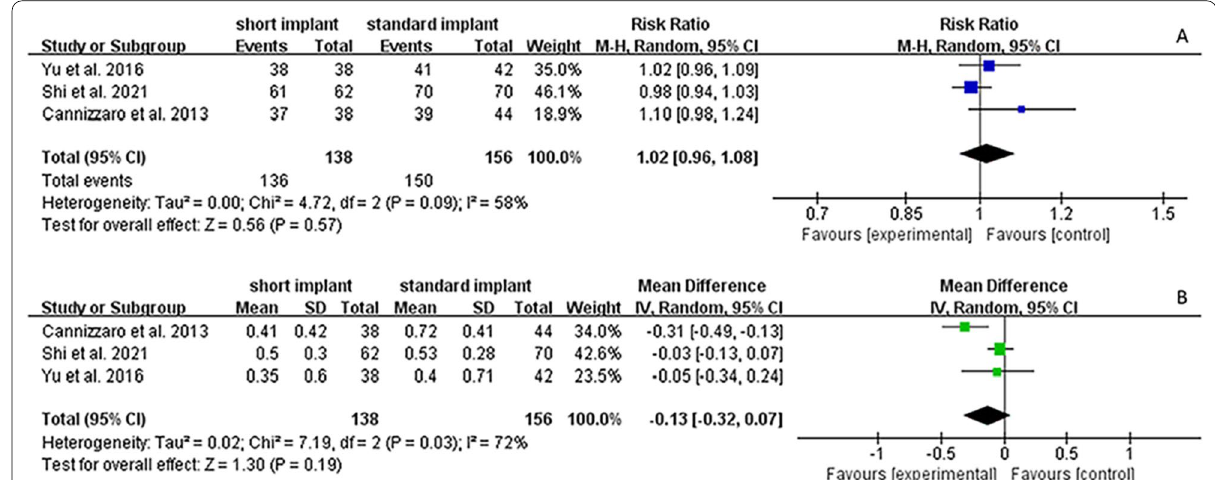
Fig. 3 Forest plots for the survival rate and marginal bone loss of included studies. A Forest plot for risk ratio (RR) of failure between short implants with OSFE and standard implants with SFE in RCTs. B Forest plot for mean difference (MD) of marginal bone level changes between short implants with OSFE and standard implants with SFE. CI confidence